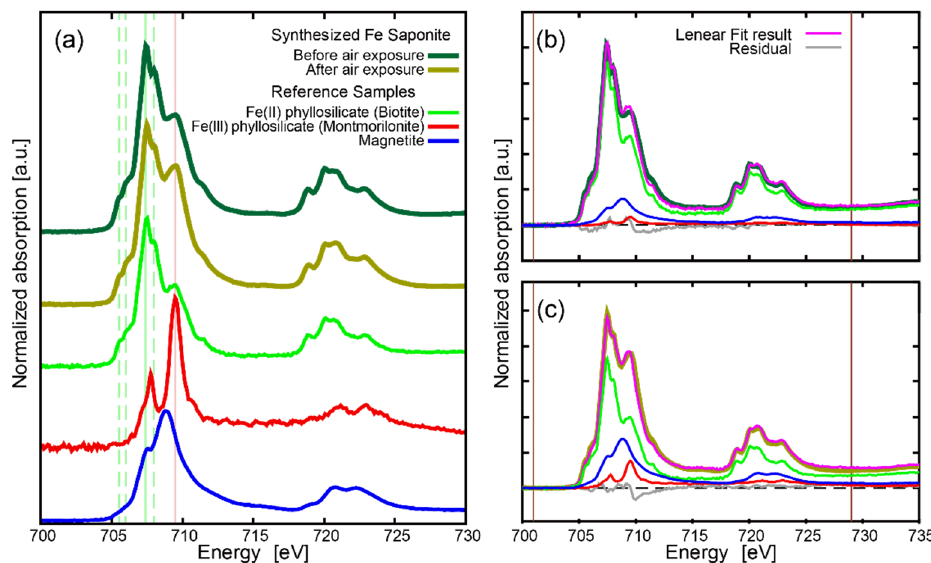
Figure 2. ( a ) Normalized XANES spectra around the Fe L-edge collected for bulk powder of synthesized ferrous saponite before and after air exposure with the reference samples, offset for clarity. Detailed descriptions about the reference samples are shown in the main text (Section 2.2.2). The X-ray energy was calibrated with an absorption edge of E0 = 707.6 eV. The vertical solid and dashed lines show the peak and shoulder energy positions, respectively, referred in the main text. ( b , c ) Results of linear combination fitting for the obtained spectra using reference data ( b ) before and ( c ) after air exposure. The pink curves in panels ( b , c ) show the sums of three reference components. The colors of the reference components in panels ( b , c ) are the same as those shown in panel ( a ). As the reference spectra of maghemite was unavailable, we could not rule out the possible presence of maghemite. The vertical brown lines show the lower and upper energy limits used for fitting. The horizontal dashed lines represent 0 in the absorption.